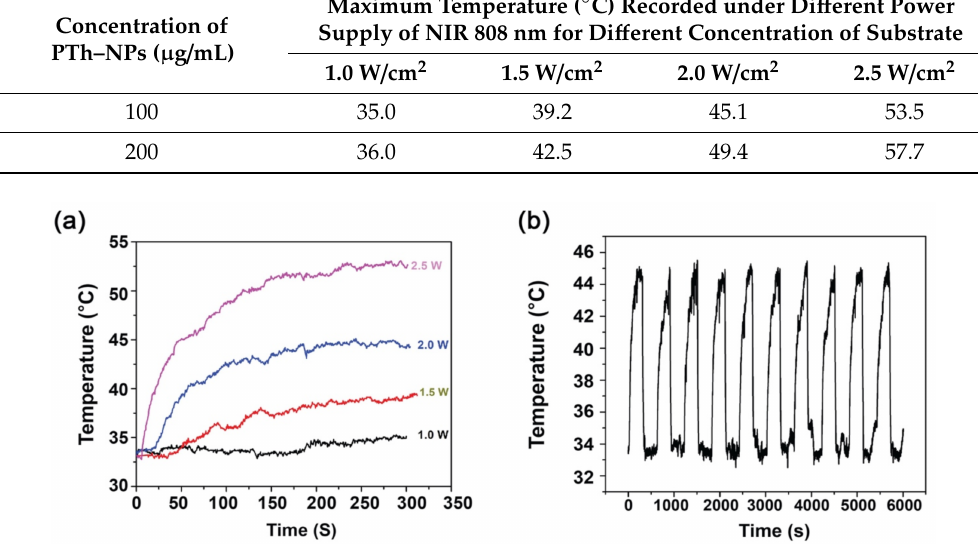
Table 1. Photothermal ability of Polythiophene nanoparticles under the 808 nm NIR irradiation at di ff erent concentration.